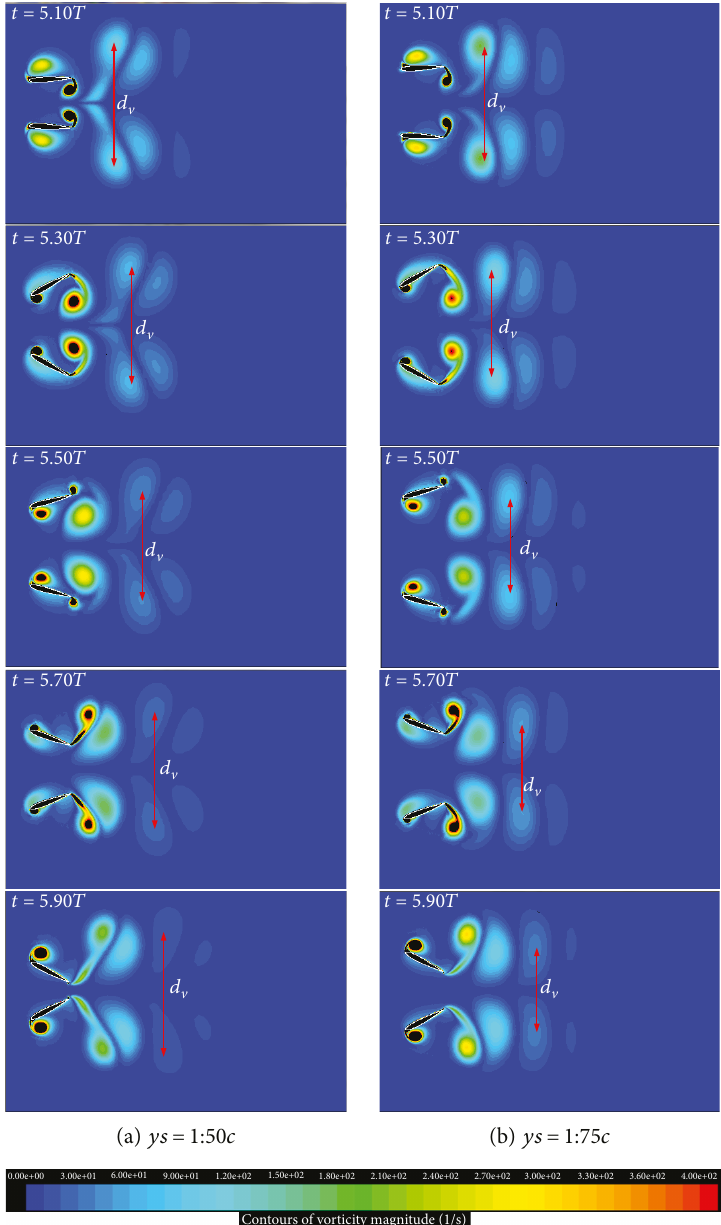
= 1 50 c and 1 75 c , ϕ = 60 ° during a fl apping s